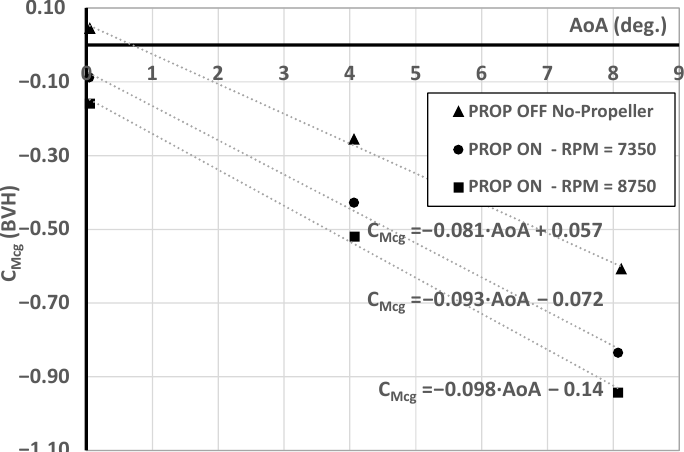
Figure 12. Global propulsive effects (direct and indirect) on the pitching moment coefficient curves for two engine design points and power-off conditions, Re = 315,000, X CG at LE MAC, IU rotation at two RPM settings.